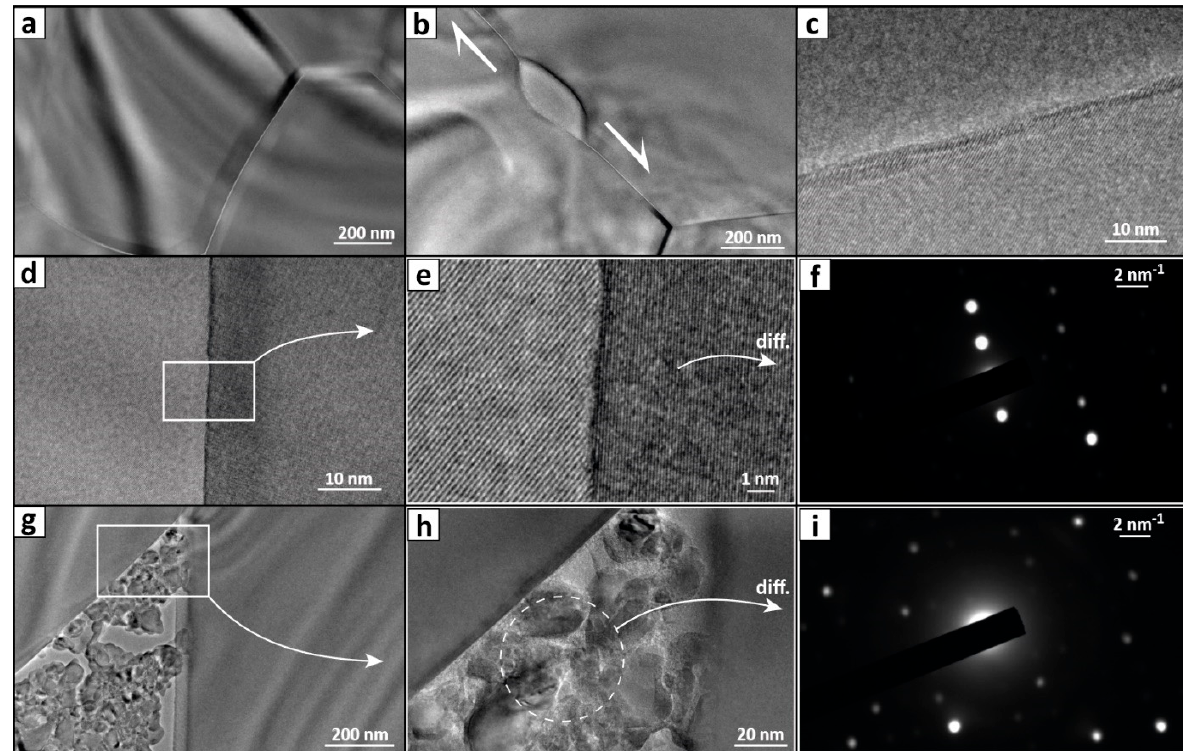
Figure 10. Transmission electron microscopy (TEM) images of the sample SP-309-1 (run KG-320). Sample deformed at 1050 °C and >100 MPa; ( a ) micrometric Mg 2 GeO 4 crystals exhibiting well-preserved triple junctions; ( b ) Interstitial nanometric grain likely highlighting GBS (white arrows) and triple junction; ( c , d ) Representative grain boundaries between micrometric olivine grains, which do not exhibit any dislocation; ( e ) Closer view on the grain boundary ( d ); ( f ) Electron diffraction pattern of a micrometric grain of olivine; ( g ) Aggregate of nanometric grains squeezed in a gap between two straight grain boundaries after GBS; ( h ) Closer view on the aggregate; ( i ) Electron diffraction pattern of the nanograined aggregates, showing the absence of amorphous material.